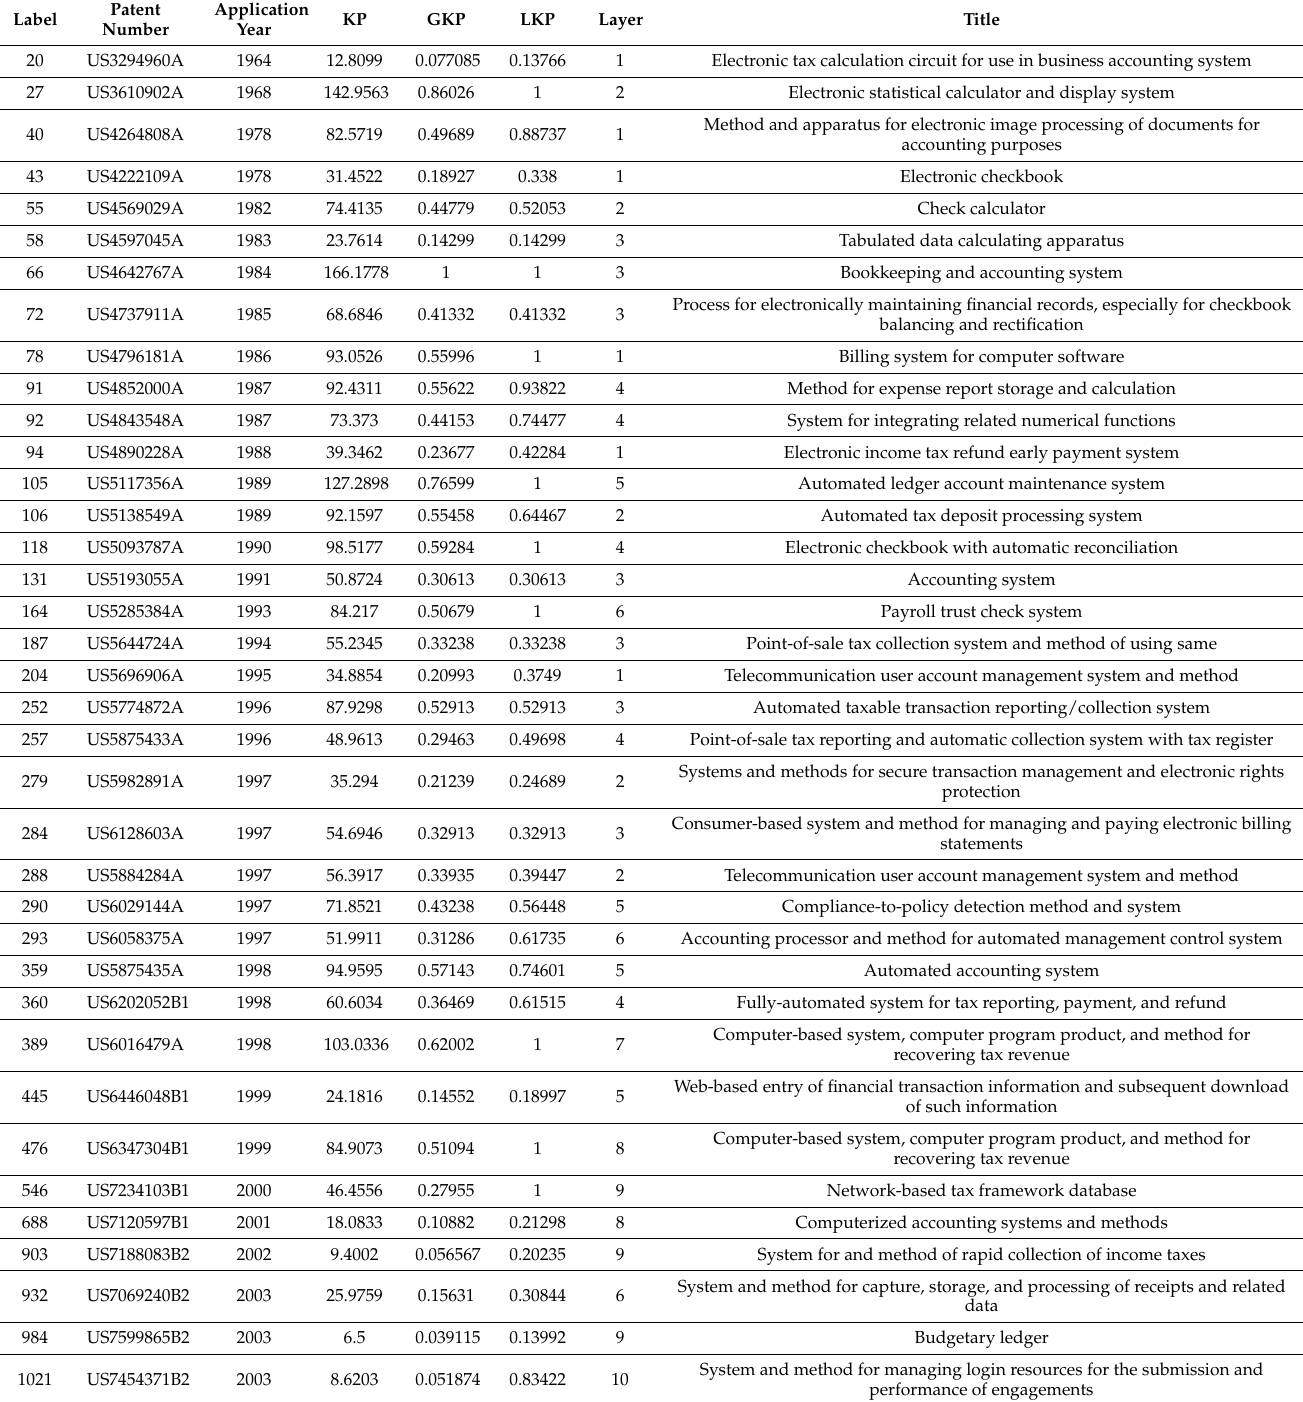
Table A1. List of patents on knowledge persistence-based main paths for accounting information